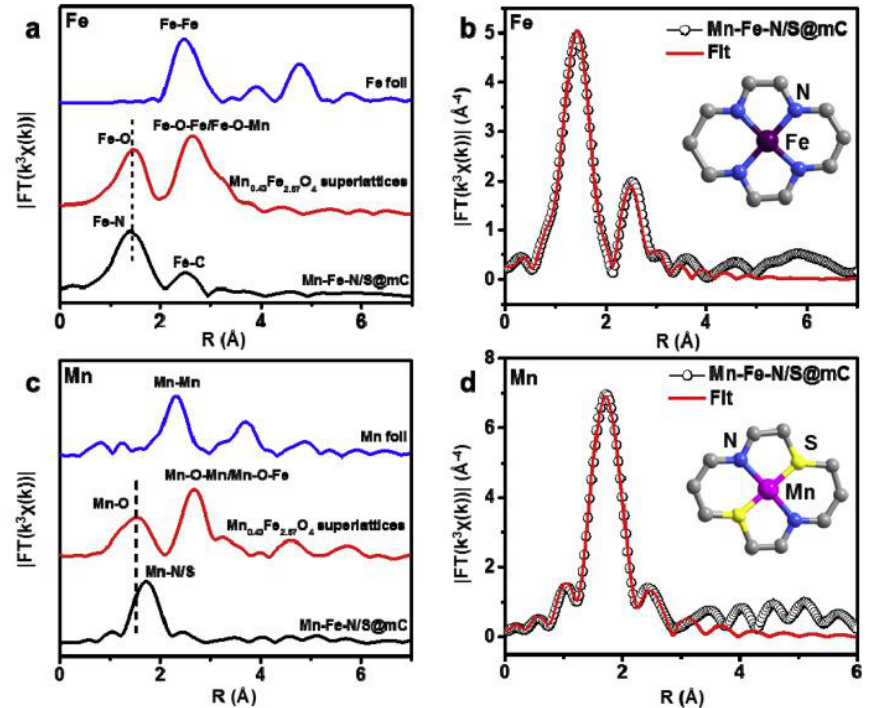
Figure 10. Fourier transform EXAFS curves of ( a ) Fe and ( c ) k 3 -weighted Mn for the prepared catalysts. the EXAFS curves of Mn 0.43 Fe 2.57 O 4 super crystals are included for comparative purposes. The corresponding K − edge EXAFS fittings of ( b ) Fe-N/S@mC for Mn-Fe-N/S@mC and ( d ) Mn. The insets show the constructions of Fe-N4 and Mn-N 2 S 2 sites. (Reprinted with permission from [119]. Copyright 2019, Elsevier).